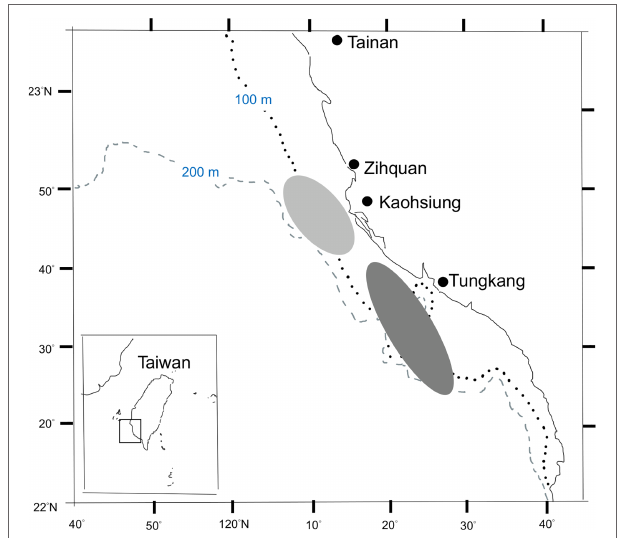
FIGURE 1 | Major fishing area of brushtooth lizardfish from the trawlers based in Zihquan (light shaded area) and Tungkang fishing ports (dark shaded